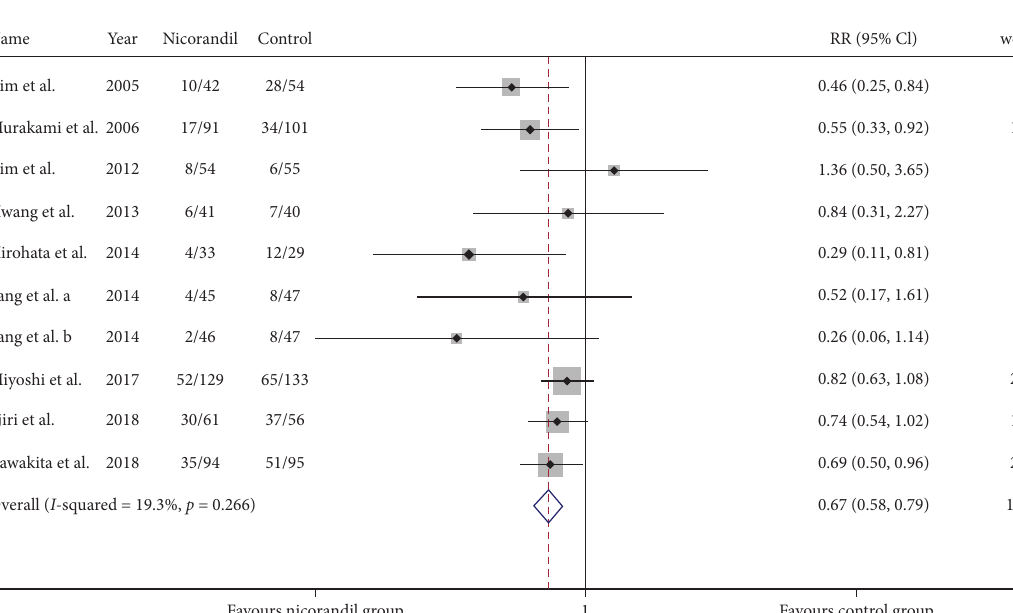
Figure 2: Comparison of PMI between the experimental group and the control group. RR � risk ratio; PMI � periprocedural myocardial